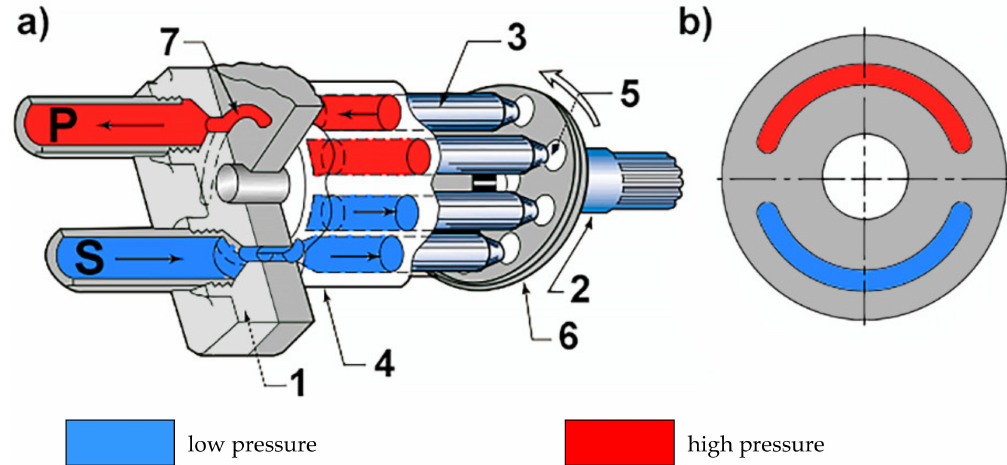
Figure 1. Axial piston pump with plate commutation unit [12]: ( a ) cross-section of the pump; ( b ) commutation plate; P—high-pressure pumping channel; S—low-pressure suction channel; 1—manifold; 2—shaft; 3—piston; 4—cylinder block; 5—slipper; 6—swashplate; 7—commutation plate.